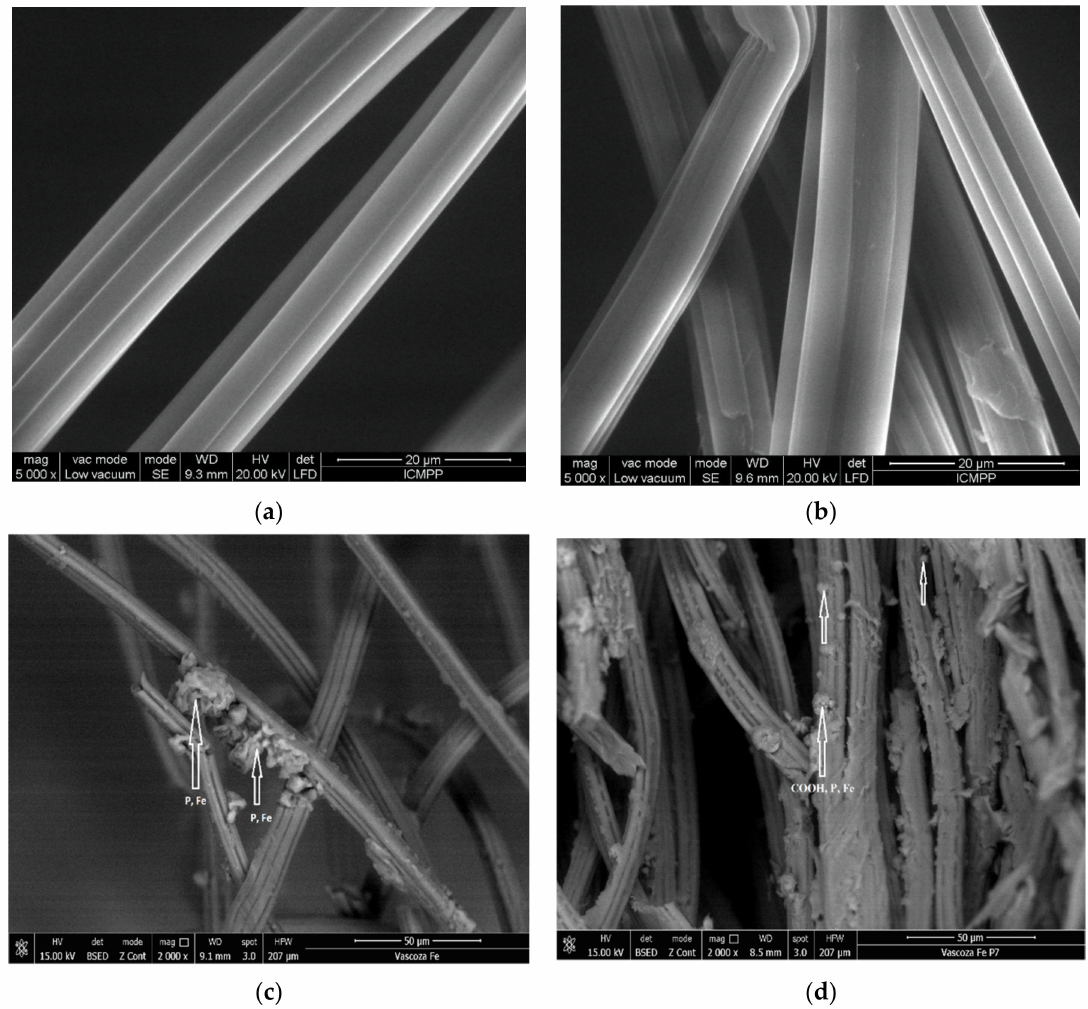
Figure 3. SEM imagines of unoxidized (V) ( a ), TEMPO-oxidized (VF) and the resulted materials, ( b ) V-DEHPA-Fe ( c ) and VF-DEHPA-Fe ( d ), viscose